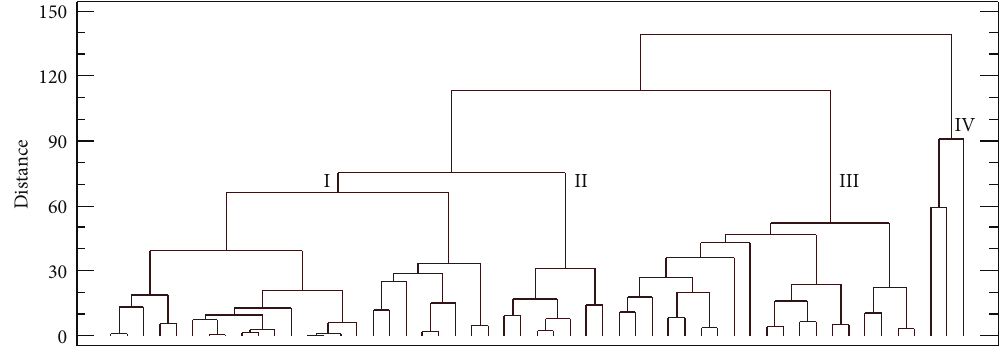
Figure 2: Dendrogram plot of tequila brands.